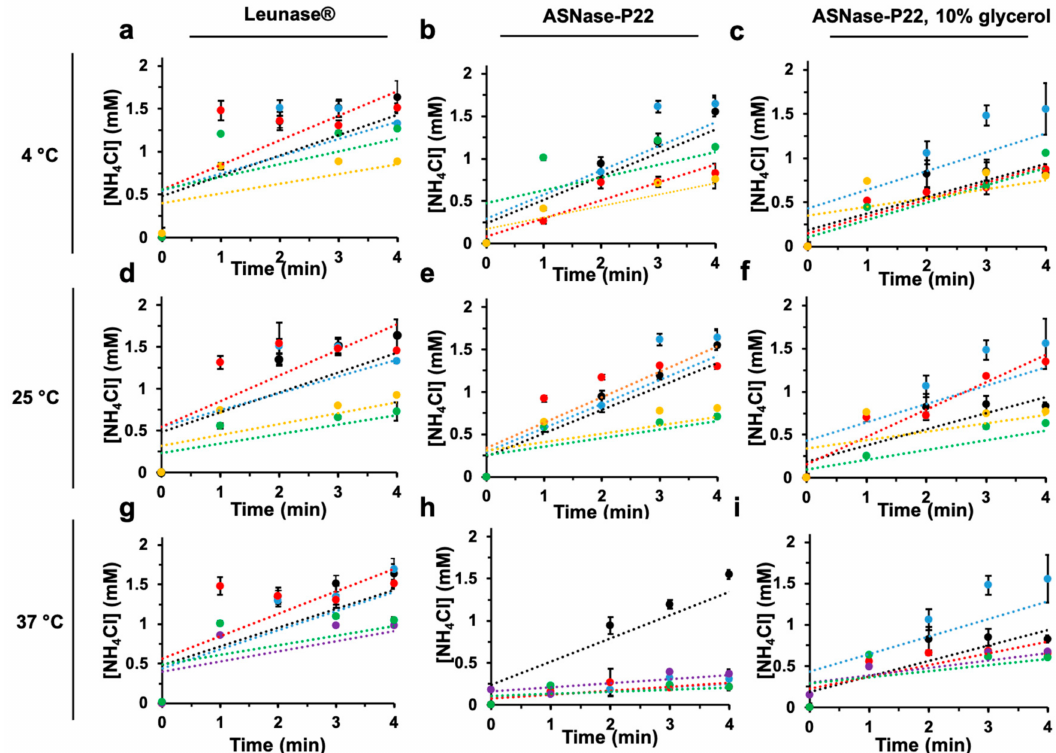
Figure 4. ASNase-P22 nanoreactors enzymatic activity at different times and temperatures of incubation. The initial rates (V0), calculated at 4, 25, and 37 ◦ C are shown, indicated on the left. ( a , d , g ) Leunase ® . ( b , e , h ) ASNase-P22 nanoreactors. ( c , f , i ) ASNase-P22 nanoreactors with 10% of glycerol. Colored lines represent incubation times of samples at given temperatures, as follows: black, 0 h; blue, 12 h; red, 24 h; purple, 48 h; green 60 h, and yellow, 168 h. ( n = 3). Error bars indicate standard